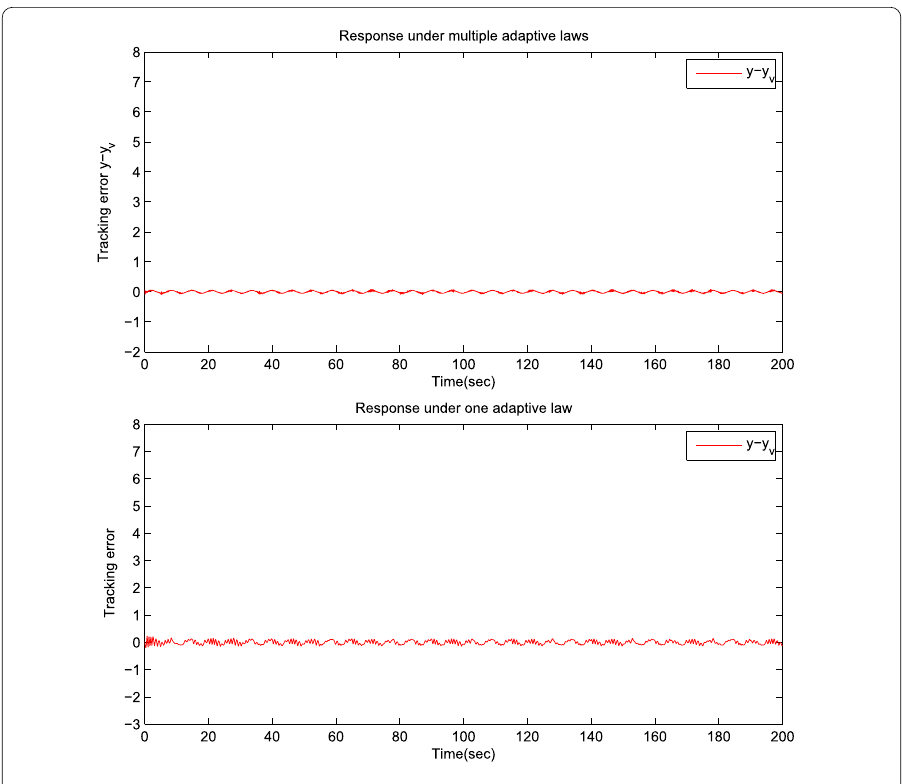
Figure 6 Responses of the tracking error of Example